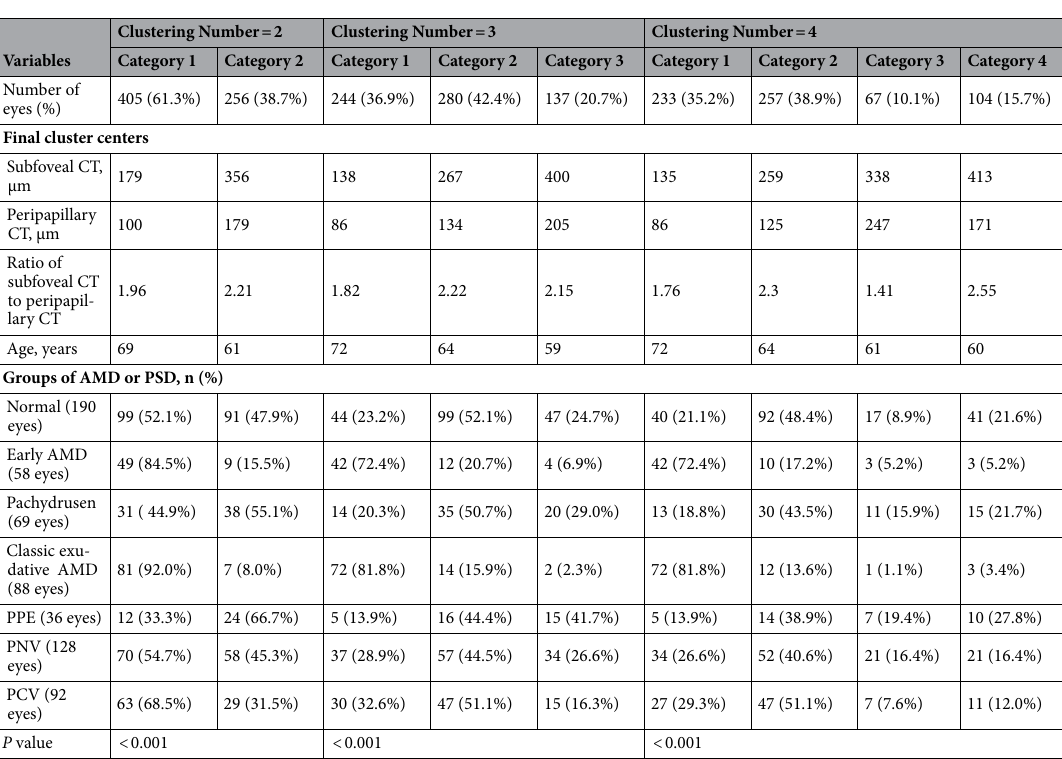
Table 6. Comparison of the distribution of age-related macular degeneration (AMD) or pachychoroid spectrum disease (PSD) between categories based on the choroidal thickness (CT) profile and age. CT, choroidal thickness; AMD, age-related macular degeneration; PSD, pachychoroid spectrum diseases; early AMD, early AMD with soft drusen or reticular pseudodrusen; PPE, pachychoroid pigment epitheliopathy, PNV, pachychoroid neovasculopathy; PCV, polypoidal choroidal